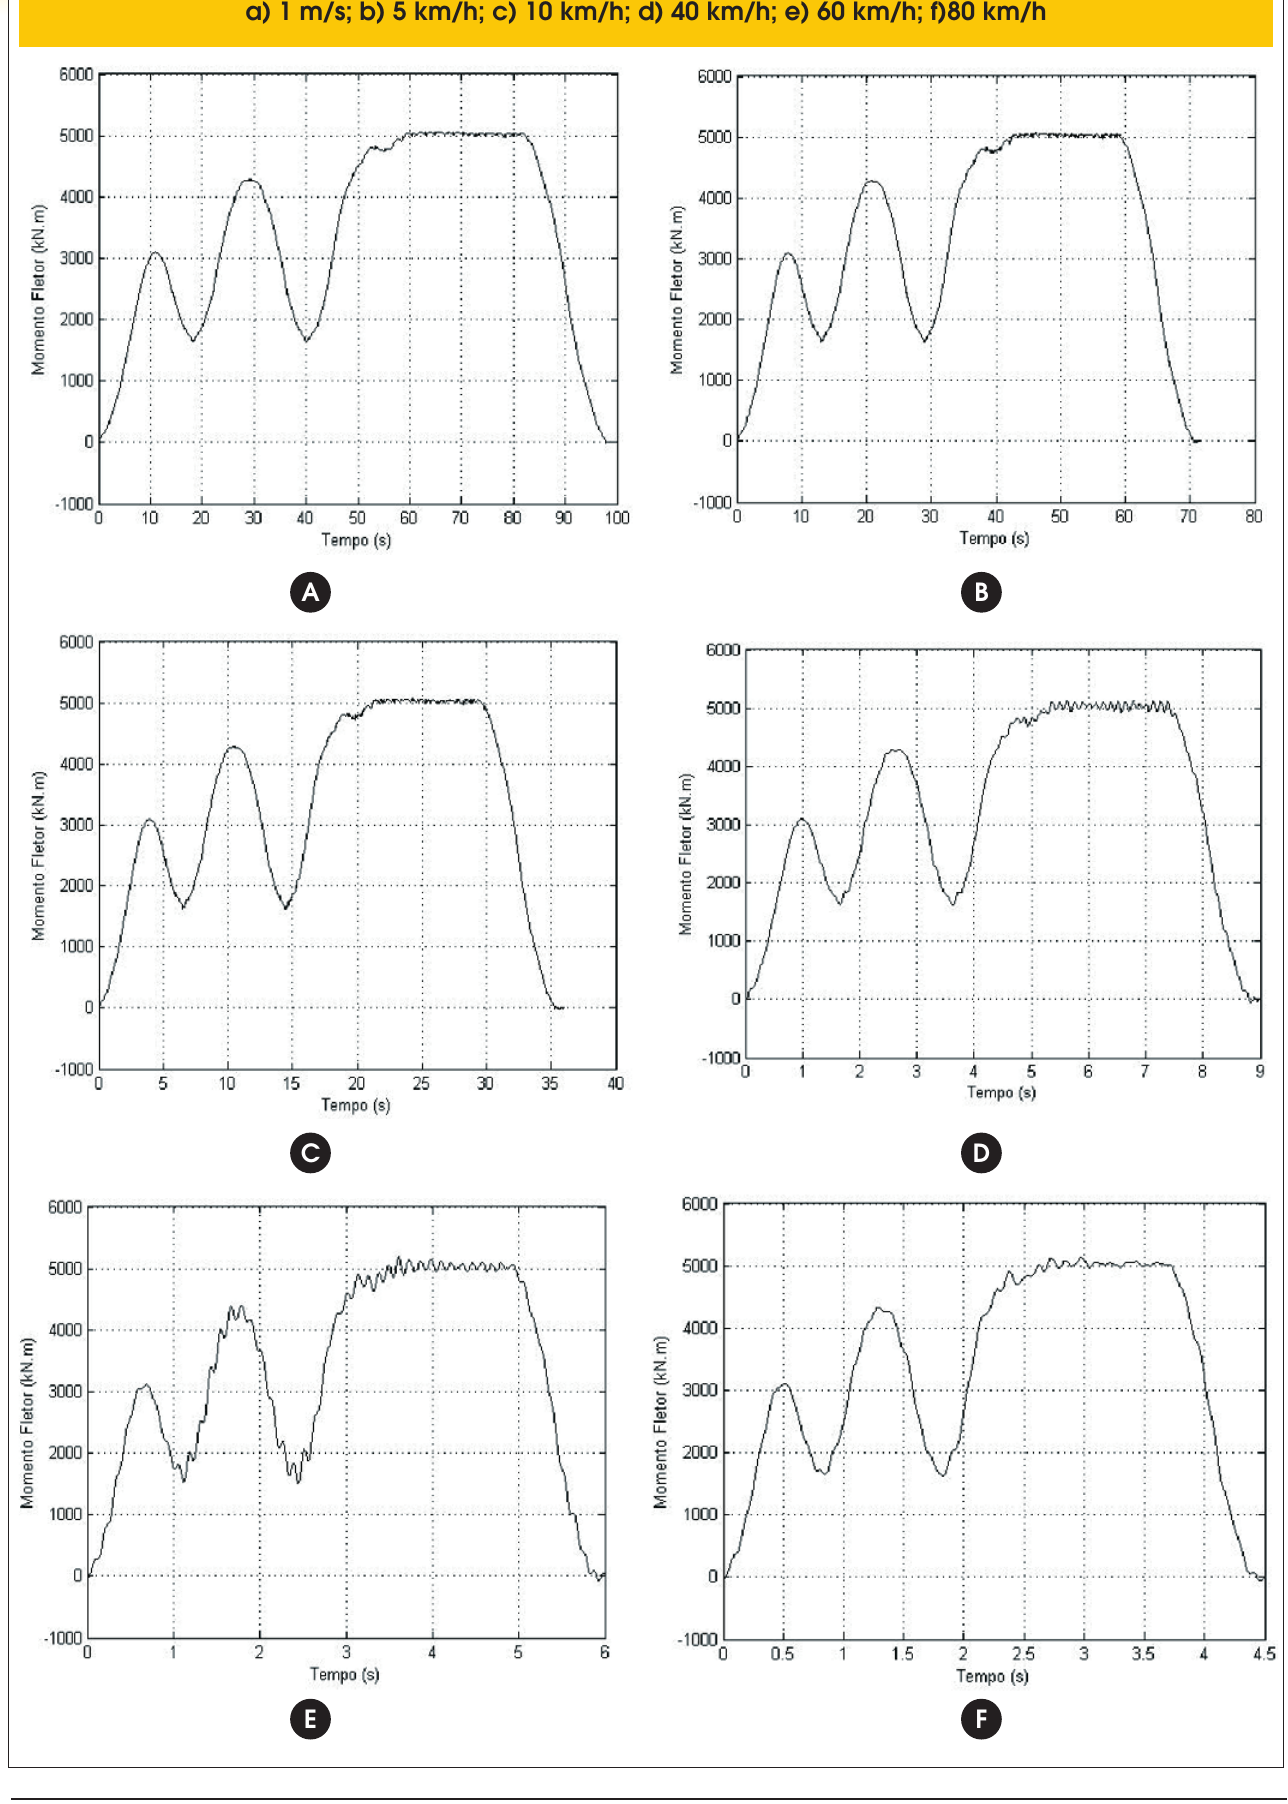
Figure 8 – Time-histories of the bending moment in the